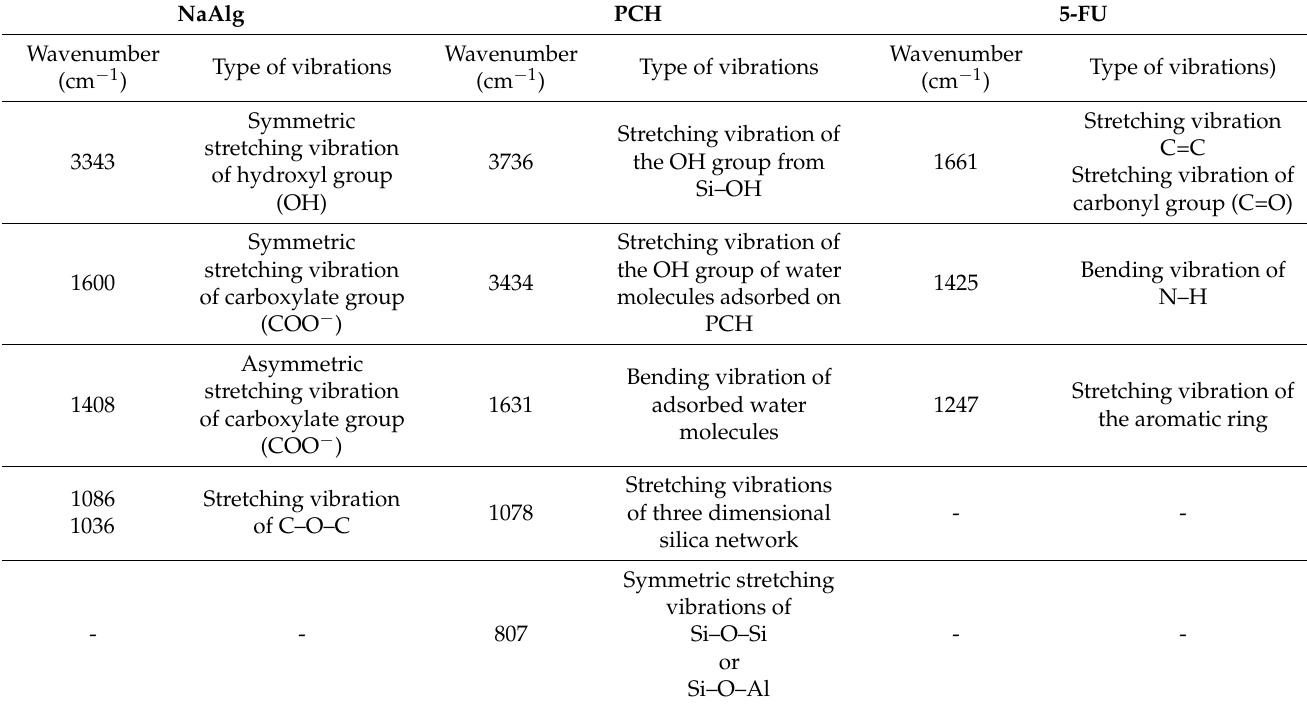
Table 1. Assignment of the characteristic peak of raw